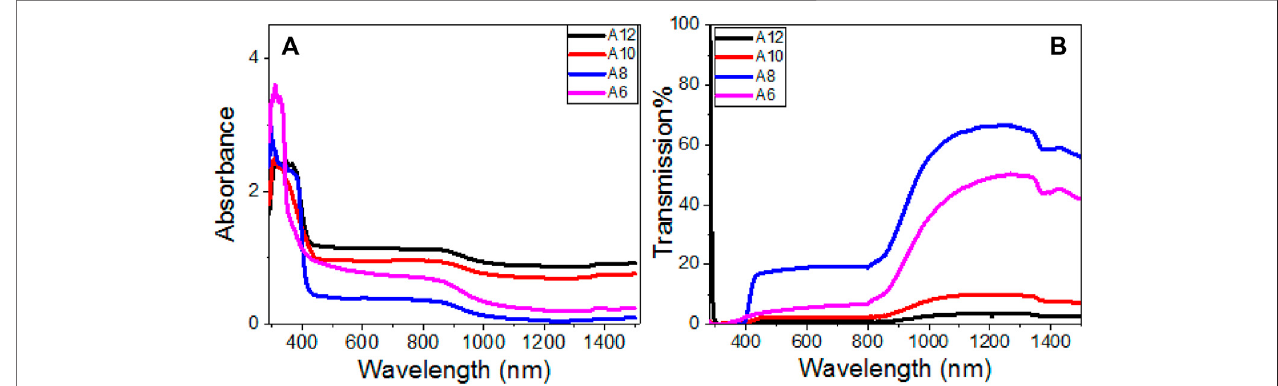
FIGURE 8 | Optical (A) absorbance and (B) transmittance spectra of An fi lms.